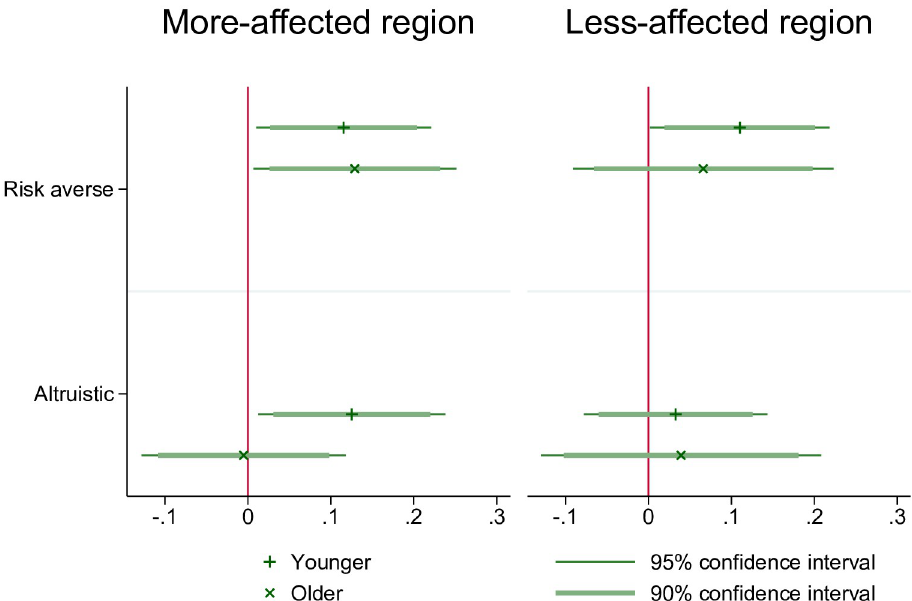
Fig 4. Motivations behind mask wearing, split by age. The presented estimates are from regressions with interaction terms between the variable of interest and being younger, controlling for all situational and individual covariates. Situational covariates include having had COVID-19 symptoms, household size, using public transport, having had contact to a COVID-19 infected person at work, having had contact to a COVID-19 infected person outside work, belonging to a COVID-19 risk group, living with a household member who belongs to a COVID-19 risk group, having traveled internationally for at least 2 days since 1st of February 2020. Individual covariates include being a health worker (doctor or nurse), age group, education group (low, medium or high level of education), being native and gender. See also the comments on Fig 3.